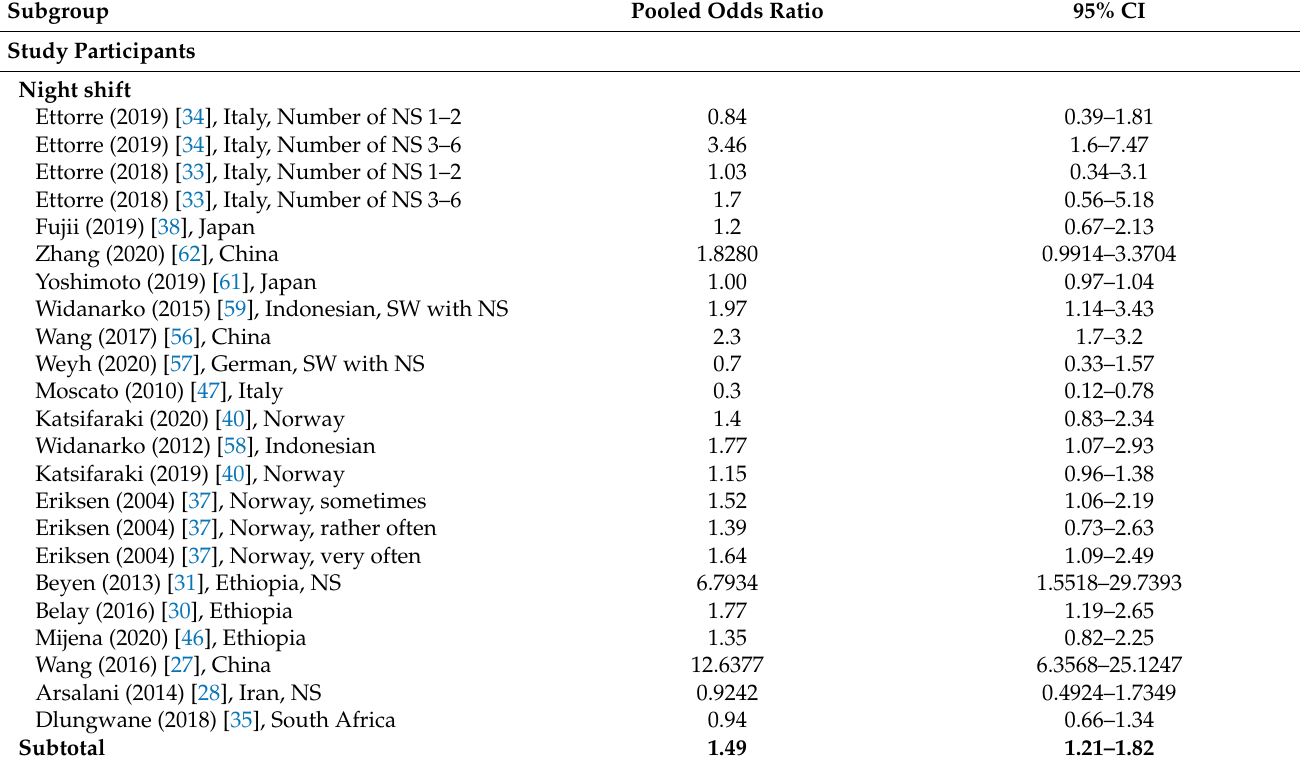
Figure 3. Figure 3. Funnel plot of log-transformed odds ratios of low back pain associated with shift work and standard errors for the 40 studies [17,27–65]. Table 2. Subgroup analysis of odds ratios based on participants exposed to night shifts or rotating